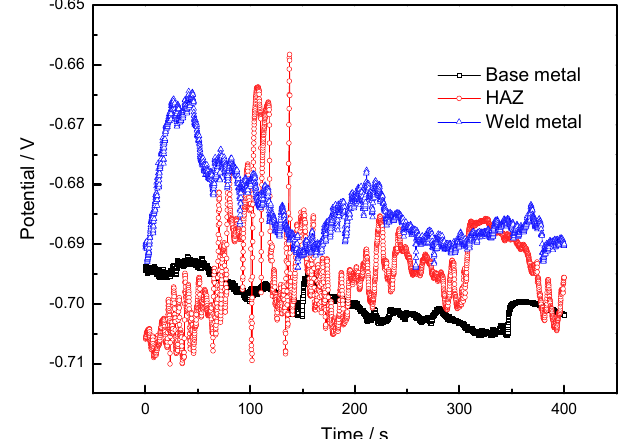
Figure 7. Corrosion potentials of the base metal, heat-affected zone and weld metal in 3.5% NaCl solution.